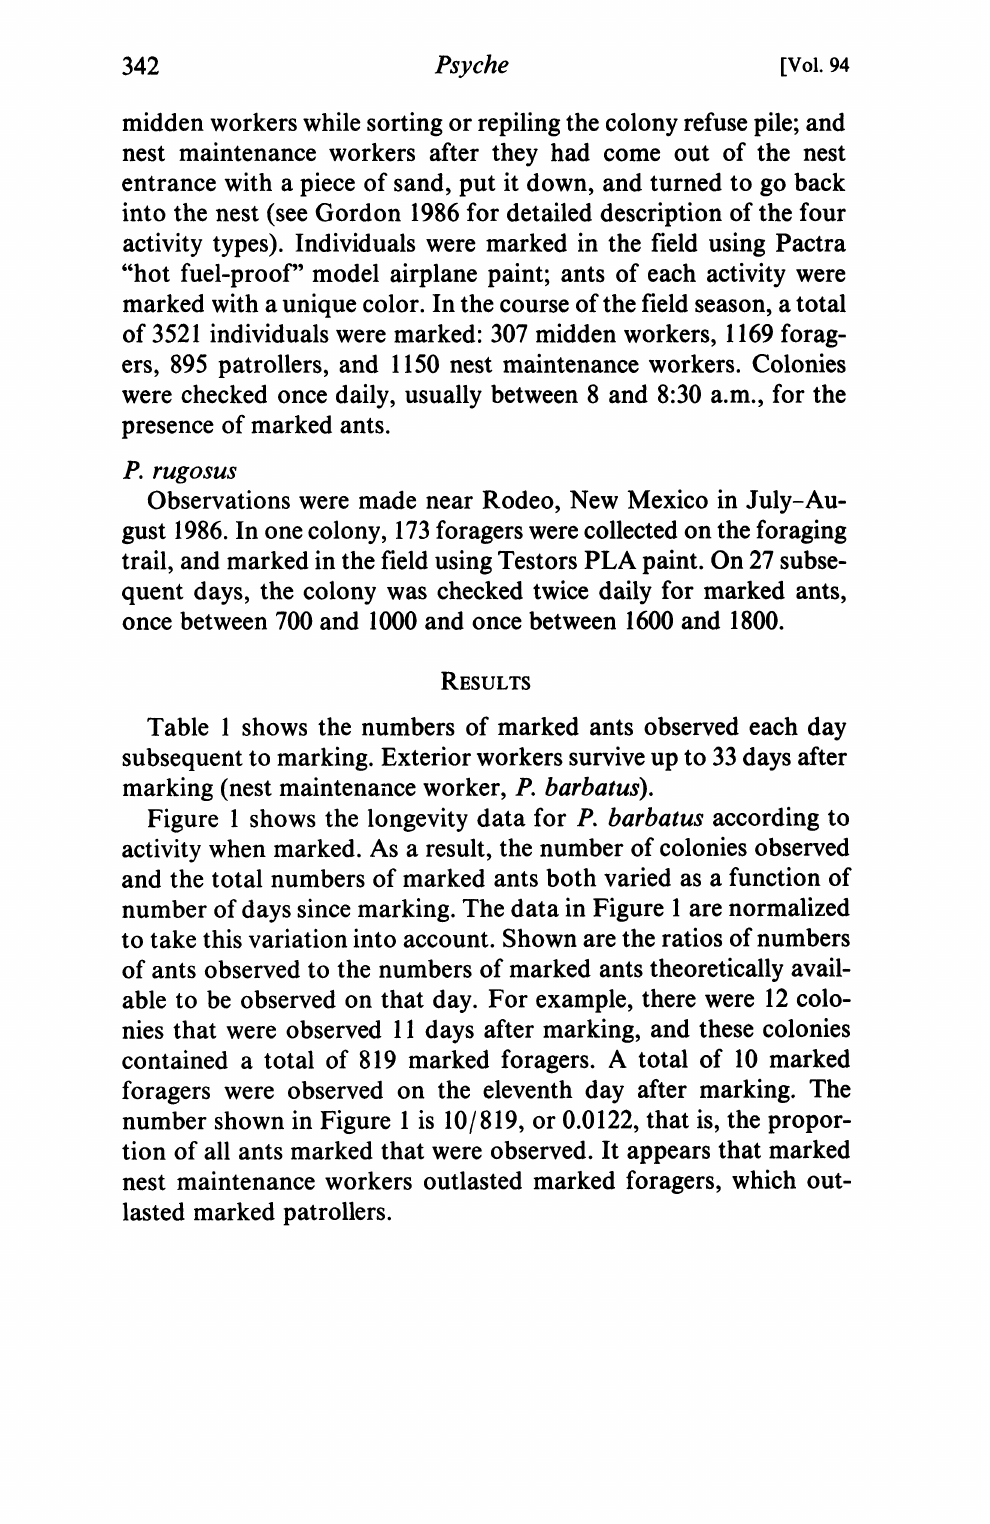
tion of all ants marked that were observed. It appears that marked nest maintenance workers outlasted marked foragers, which out- lasted marked